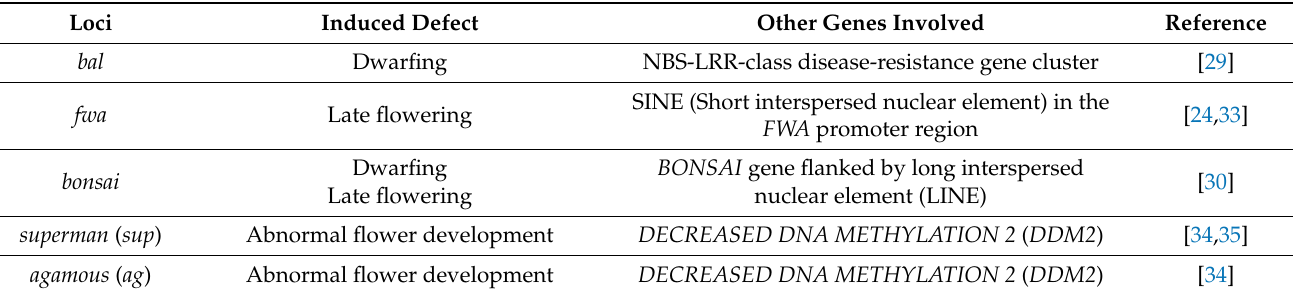
Table 1. Epialleles induced by DDM1 null mutations.